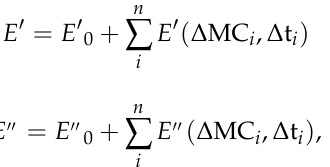
Figure 12. Relations of E ″ 1Hz / E ″ 20Hz and MC d during the RH isohume periods (30%, 60%, and 90% RH).